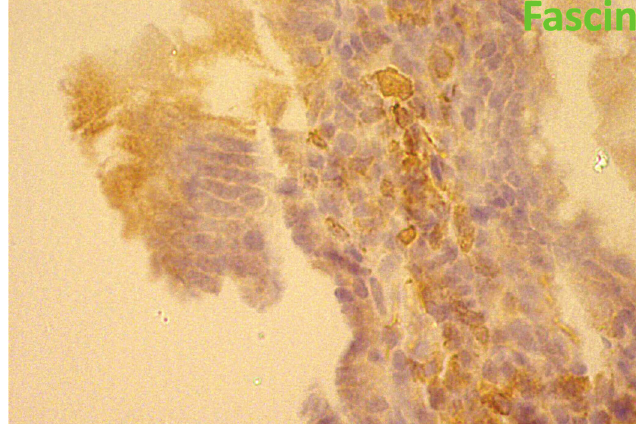
Figure 2 - Fascin expression in the small intestine of a rat orally exposed to E407a during 2 weeks. Fascin is upregulated in the stroma. Furthermore, fascin staining can be noticed in the small intestinal epithelial lining.